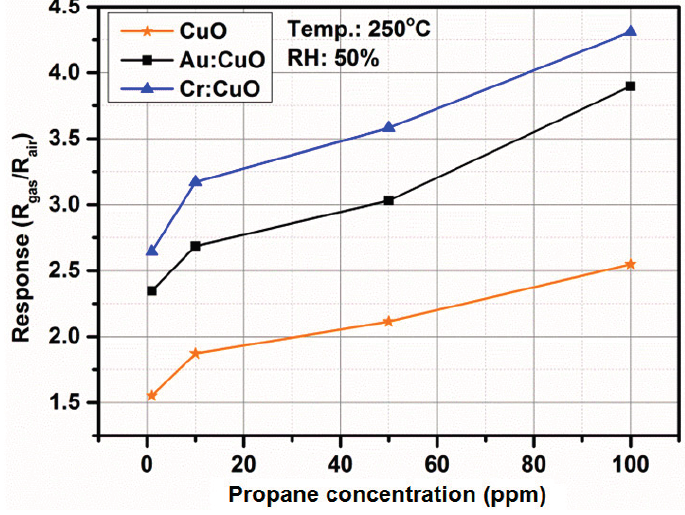
Figure 14. The gas response of the CuO-based, Cr:CuO-based and Au:CuO-based sensors as a function of propane